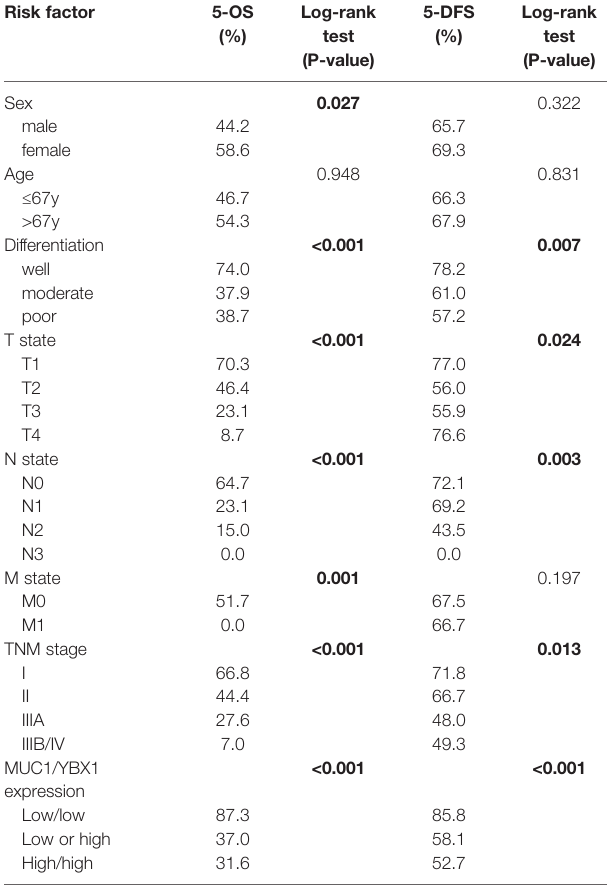
survival on different clinicopathological factors using Kaplan – Meier method. Risk factor